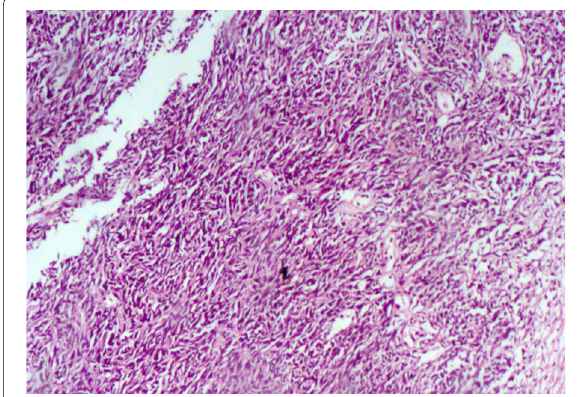
Fig. 3 Photomicrograph showing pleomorphic spindle-shaped cells disposed in sheets and short fascicles consistent with malignant peripheral nerve sheath tumour. (Haematoxylin and eosin stains, X100)